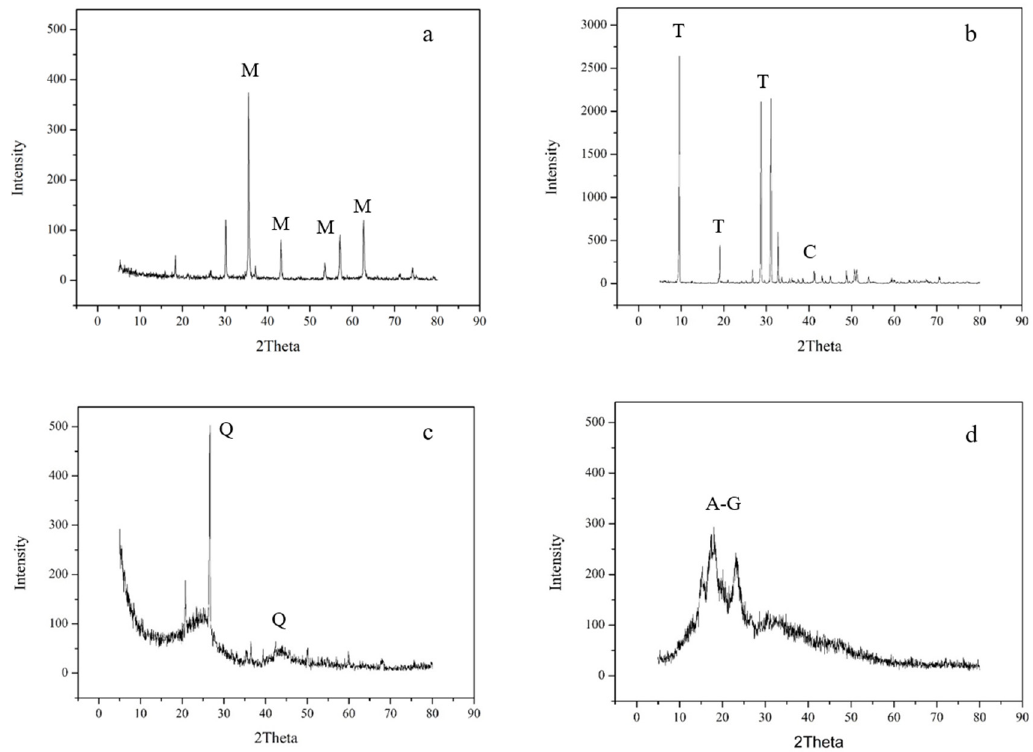
Figure 2. X-ray diffraction (XRD) of ( a ) magnetite, ( b ) talc, ( c ) activated carbon, and ( d ) cornstarch (M: magnetite; T: talc; C: calcite; Q: quartz; A-G: amylose–lipid complex in granules). (M: magnetite; T: talc; C: calcite; Q: quartz; A-G: amylose–lipid complex in